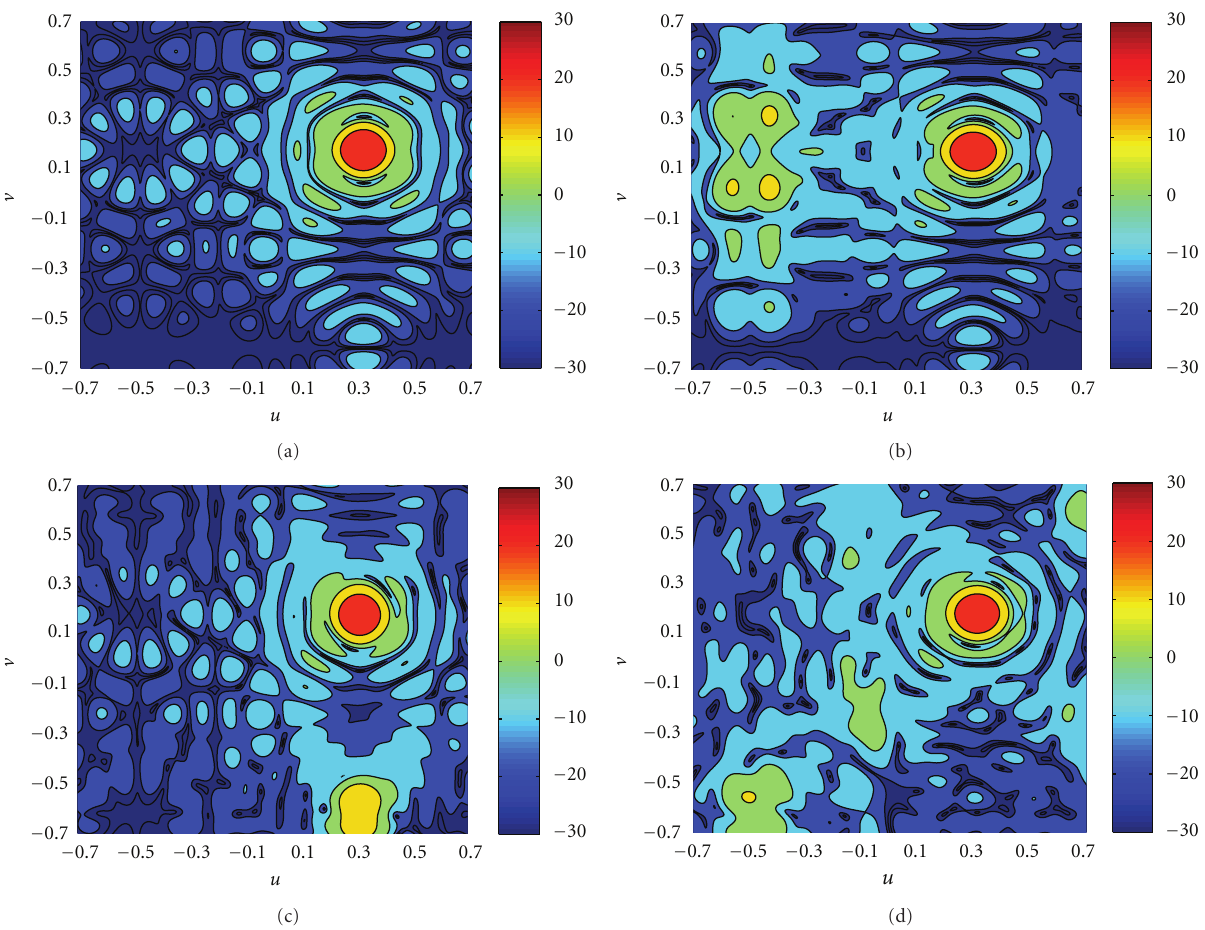
Figure 7: Radiation patterns produced with the pencil-beam reflectarray antenna using di ff erent lattices. (a) Without any grouping. (b) Grouping along the x -axis. (c) Grouping along the y -axis. (d) Grouping in an irregular lattice.